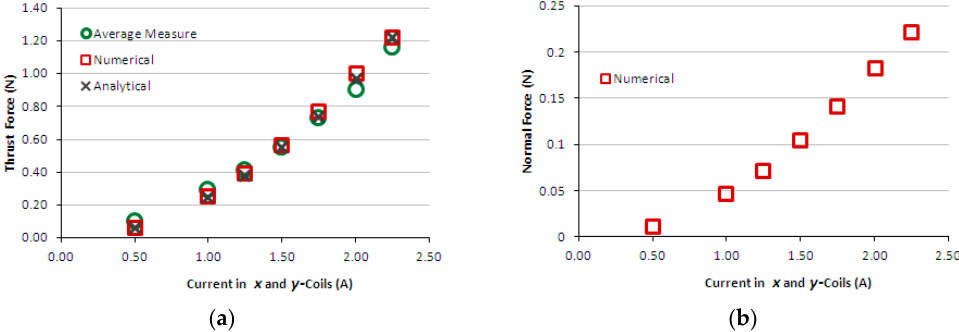
Figure 12. Case 2: ( a ) thrust force and ( b ) normal force produced by the induction planar actuator when both x and y -winding are under current. Sensors 2016 , 16 , 407